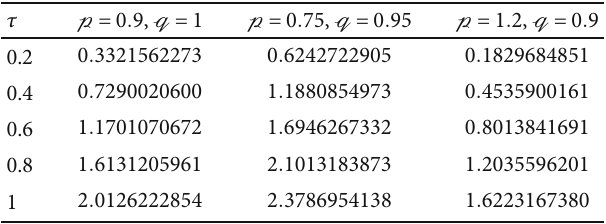
Table 2: Numerical results of the Riccati equation for various values of p and q .